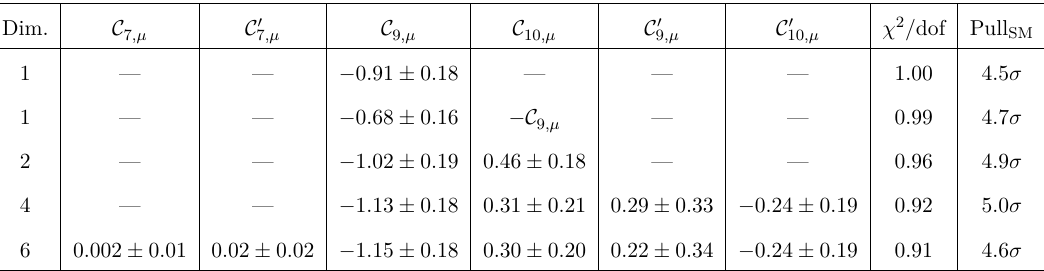
Table 9 . Best fit values and 1 σ uncertainties of the Wilson coefficients from a fit with only pure b → s µ + µ − data for different new physics scenarios. We also provide the χ 2 / dof value and respective pull from the SM hypothesis.